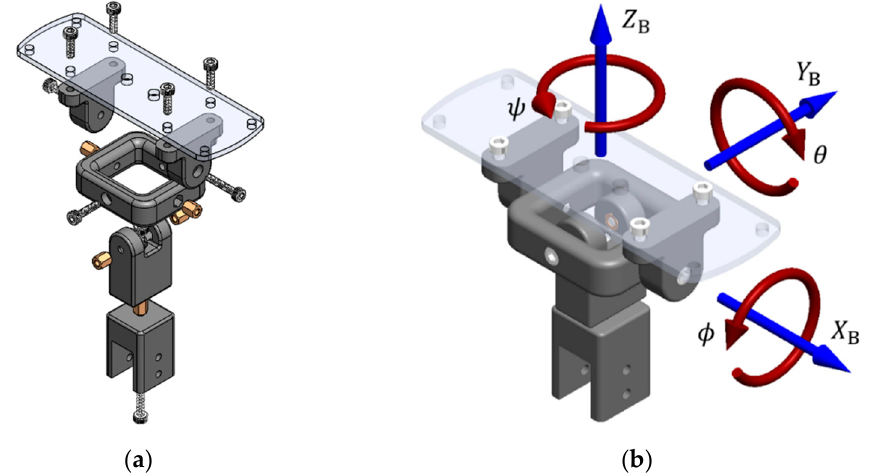
Figure 15. 3 DOF gimbal joint: ( a ) parts; ( b ) assembly.